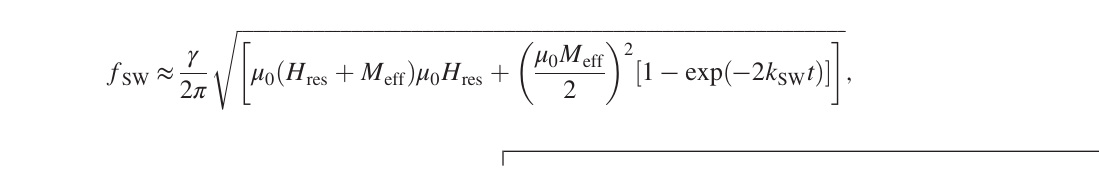
where t is the Ni 8 Fe 2 thickness (6 nm). By fitting the SW resonance, corresponding to the peak in the absolute of Δ S 12 [ ¼j Δ S 12 j , Figs. 4(a) and 4(b)], to this dispersion relation- ship, we extracted the k and μ 0 M values (Sec. VI of SW eff Supplemental Material [17]) for the Ni 8 Fe 2 layer. In addi- tion, we deduced the SW attenuation length λ [insets of SW Figs. 4(c) and 4(d)] from the fact [40,41] that the SW intensity, defined as the maximum peak-to-valley height of the real part of Δ S 12 [ ¼ Re ½ Δ S 12 (cid:3) , Figs. 4(a) and 4(b)], exponentially decays with increasing d : exp ½ − ð d= λ Þ(cid:3) . SW τ = ∂ k Here, λ , υ ¼ υ ¼ 2 π ð ∂ f Þ is the group g g SW pres SW SW velocity, and τ ¼ f αγ ½ μ 0 ð 2 H þ M Þ(cid:3)g − 1 is the mag- pres res eff netization precession time.